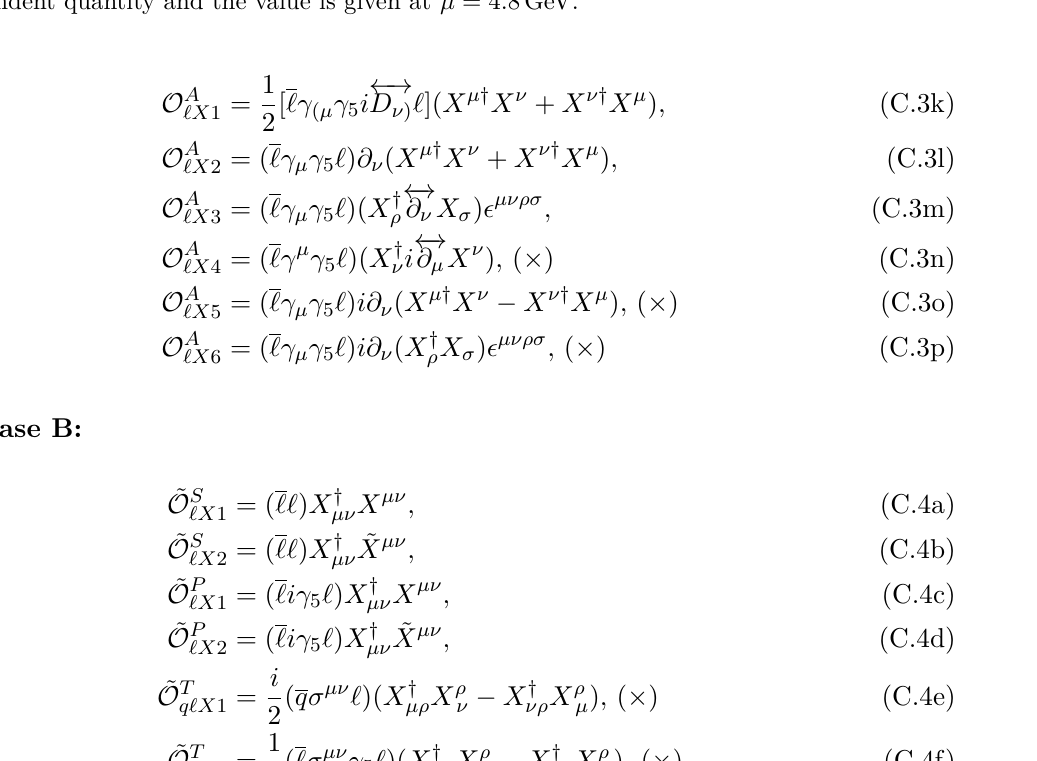
Table 4 . Parameters appearing in the form factors of the B → K ( π ) transitions [48]. f T is a scale-dependent quantity and the value is given at µ = 4 . 8 GeV